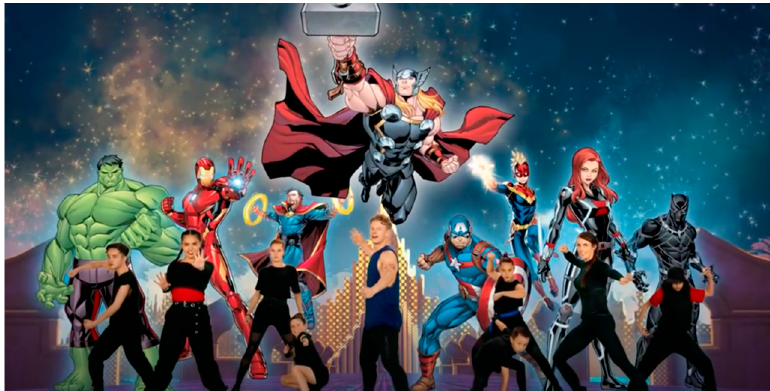
Figure 1. Move Like the Avengers Characters and Instructors.